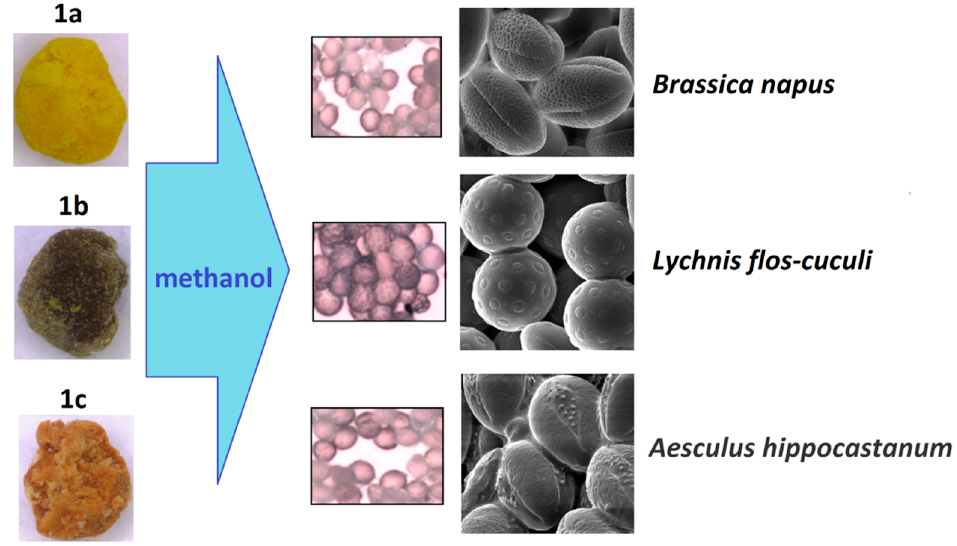
Figure 6. Microscopic identification of pollen grains in methanol extracts from yellow, green, and reddish loads ( 1a – c ) of BP1 .